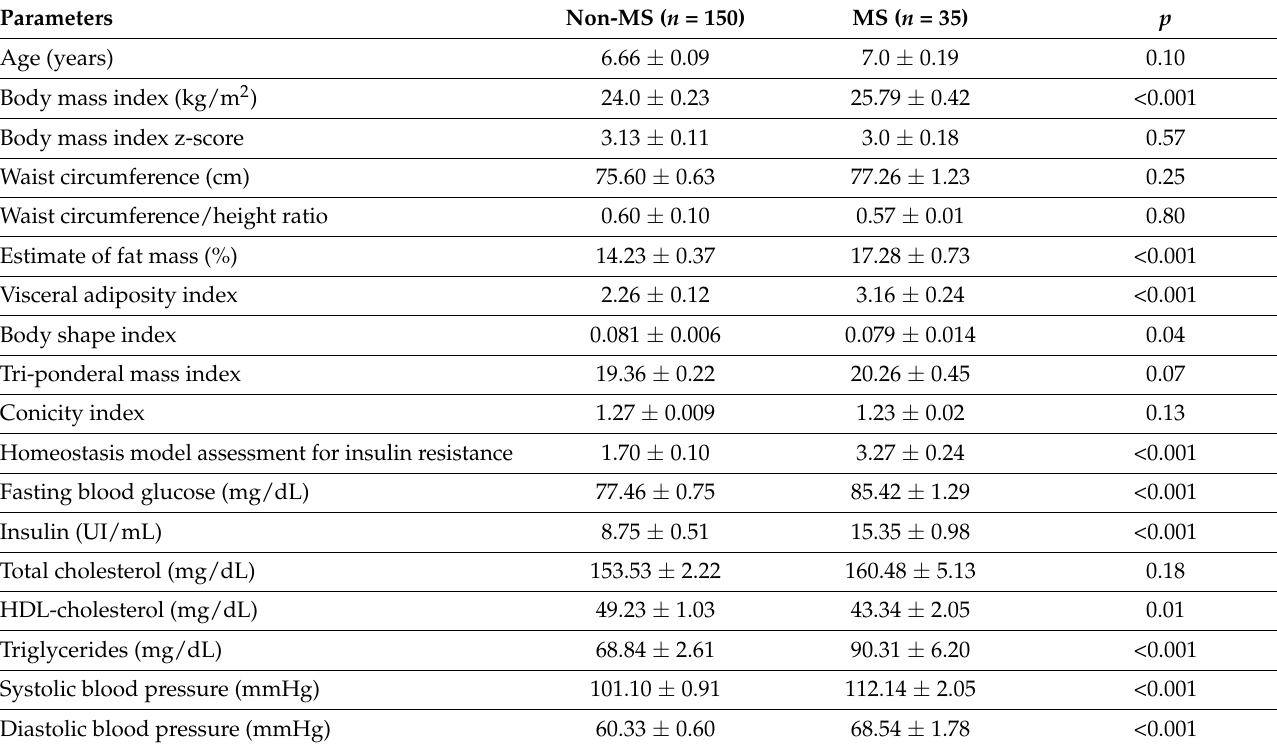
Table 3. Clinical and biochemical data in patients with and without metabolic syndrome.